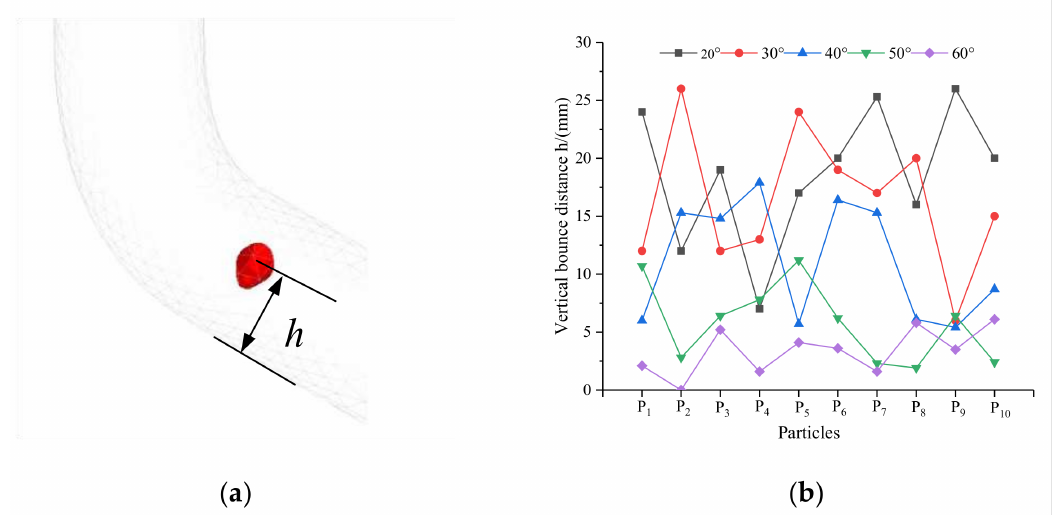
Figure 13. Effects of different ejection angles on seed motion: ( a ) defines the bounce heights of the seeds, ( b ) is the bounce heights of seeds with different ejection